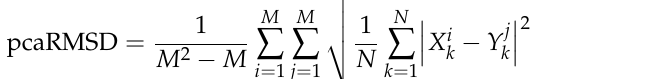
Scoring of protofilament models. A straightforward scoring method has been pro- posed to evaluate and select the most reliable structure of protofilaments for the further construction of amyloid fibril models. Since amyloid fibrils consist of a large number of identical peptide chains forming long stacks of β -sheets with a quasi- translational symmetry along the long fibril axis [23], all peptide monomers in the predicted protofilament model should have very similar chain conformations. We used the symmetry criteria to select the best models of protofilaments. Therefore, for each model, we defined the peptide-chain-average-RMSD parameter (pcaRMSD). The value of pcaRMSD was calculated for each protofilament model using the set of RMSD values obtained during the mutual comparison of all 5 monomers. The RMSD value for each peptide pair was calculated after the structural fitting of two monomers. In this way, the conformations of 5 peptides were compared with each level of translational symmetry of monomers within the protofilament structure. The